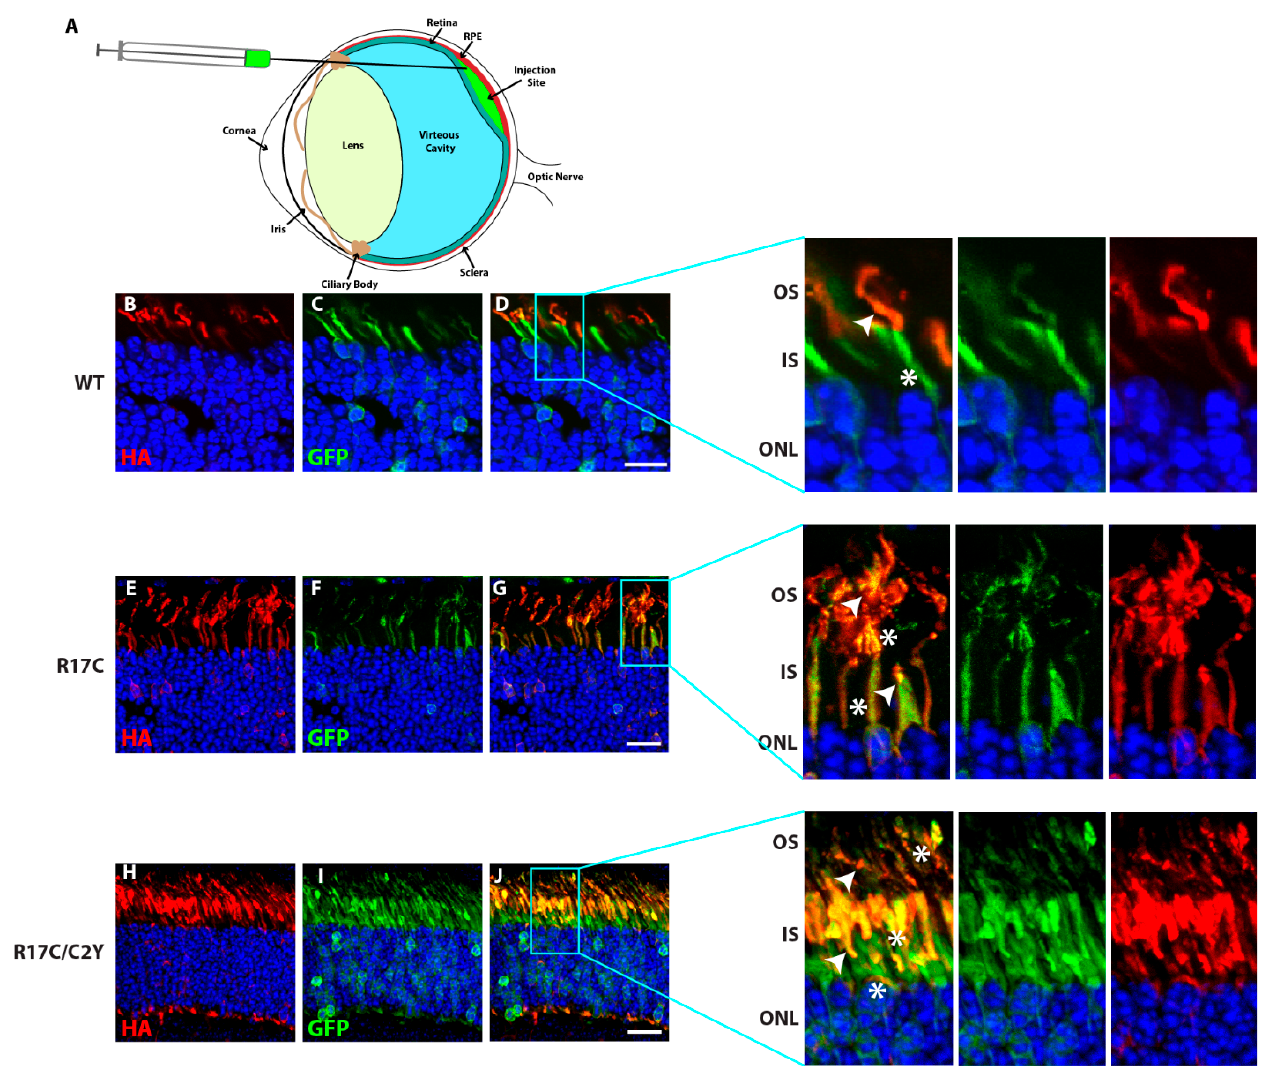
Figure 5. Additional palmitoyl lipid modification in PRCD does not rescue its localization to the photoreceptor OS and remains severely mislocalized in the IS. ( A ) Illustration depicting the delivery of various PRCD constructs into the subretinal space. ( B – J ) Subretinal injection followed by electroporation of HA-tagged PRCD-WT ( B – D ), R17C ( E – G ), and R17C/C2Y ( H – J ) double mutants in CD1 mouse retina. Localization of PRCD-WT in the photoreceptor OS (B-D and expanded images in the right panel highlighted). In contrast, PRCD-R17C is localized to both the OS and IS ( E – G ) and expanded image in the right panel), and R17C/C2Y is highly mislocalized to the IS. The white arrow depicts HA localization, and the white asterisk shows GFP location in the photoreceptor. GFP (green) serves as a transfection control localized to the photoreceptor IS as described in earlier studies. The right panels are magnified to show the localization patterns of PRCD proteins. Wild-type PRCD is ex- clusively expressed in photoreceptor OS, and R17C shows both mislocalizations to the IS and normal localization in OS, whereas the majority of double mutant PRCD-C2Y/R17C protein is mislocalized to the inner segment. Scale bar 20 µ